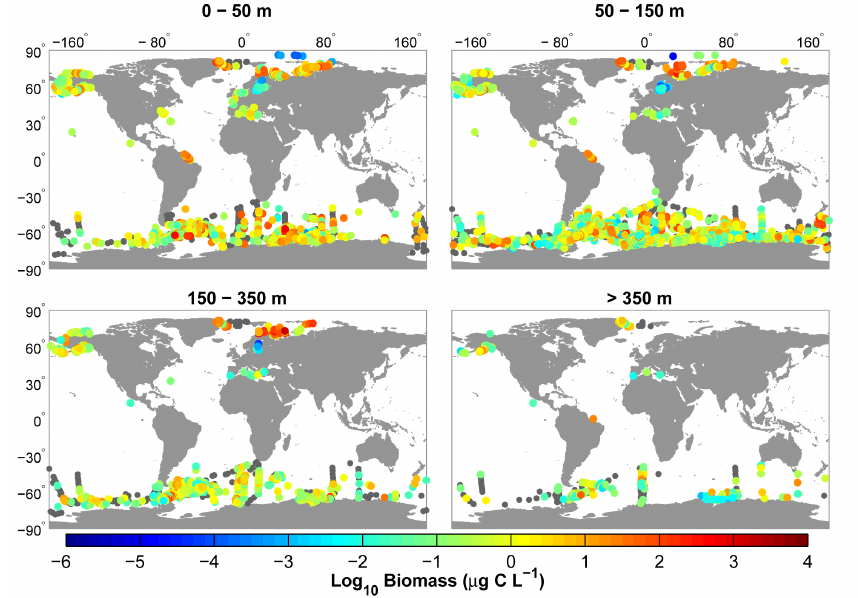
Figure 3. Global distribution of macrozooplankton biomass ( µ gCL − 1 ) at di ff erent depths. Grey points represent zero